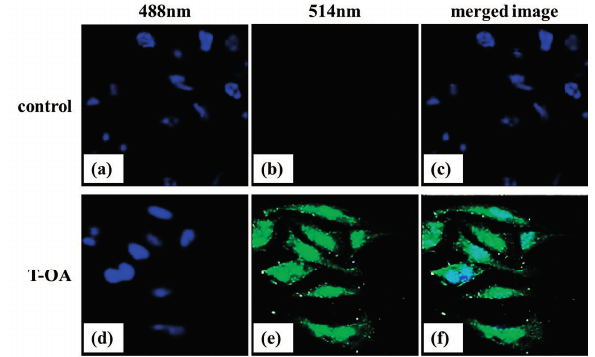
Figure 7. Immunohistochemical analysis of NF- κ B/p65 ( I ) and COX-2 ( II ) in control and T-OA treated groups of Bel-7402 cells. ( Ia ) Control group without T-OA; ( Ib ) Treated with 5 µM T-OA; ( Ic ) Treated with 10 µM T-OA; ( Id ) Treated with 20 µM T-OA; ( IIa ) Control group without T-OA; ( IIb ) Treated with 5 µM T-OA; ( IIc ) Treated with 10 µM T-OA; and ( IId ) Treated with 20 µM T-OA. (×400).